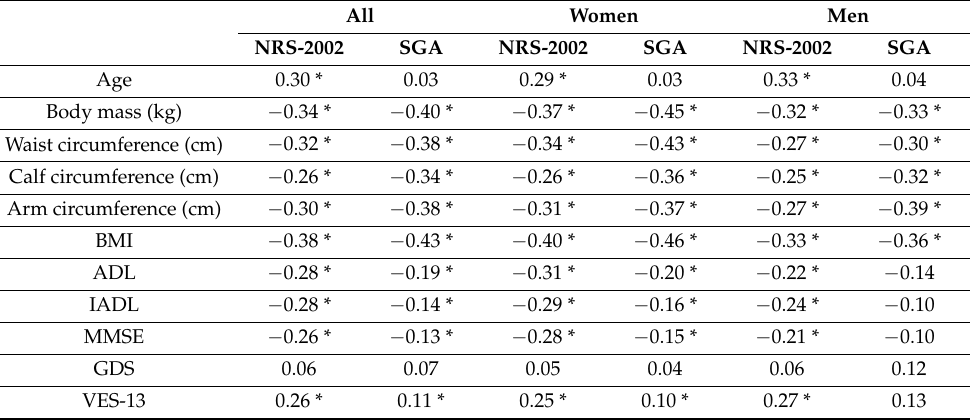
Table 4. Spearman correlation coefficients of NRS-2002 and SGA with age, anthropometric data and other Comprehensive Geriatric Assessment